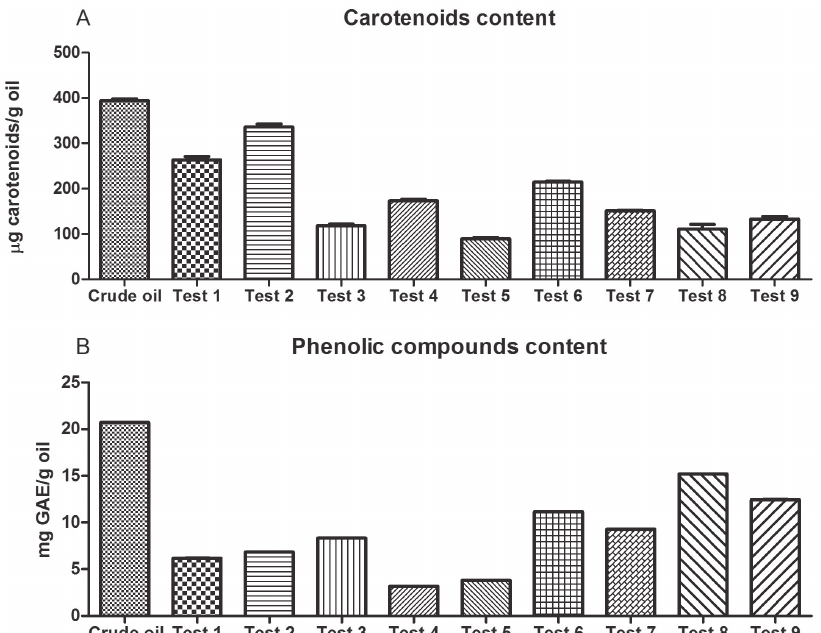
FIGURE 4 - Total carotenoids (A) and phenolic compounds (B) of Attalea phalerata Mart. pulp oil (crude and microcapsules), obtained by complex coacervation at different process conditions. Means of tests performed in triplicate. Test 1 (5 g, 40 °C, 12000 rpm), test 2 (10 g, 40 °C, 12000 rpm), test 3 (5 g, 60 °C, 12000 rpm), test 4 (10 g, 60 °C, 12000 rpm), test 5 (5 g, 40 °C, 18000 rpm), test 6 (10 g, 40 °C, 18000 rpm), test 7 (5 g, 60 °C, 18000 rpm), test 8 (10 g, 60 °C, 18000 rpm) and test 9 (7.5 g, 50 °C, 18000 rpm).